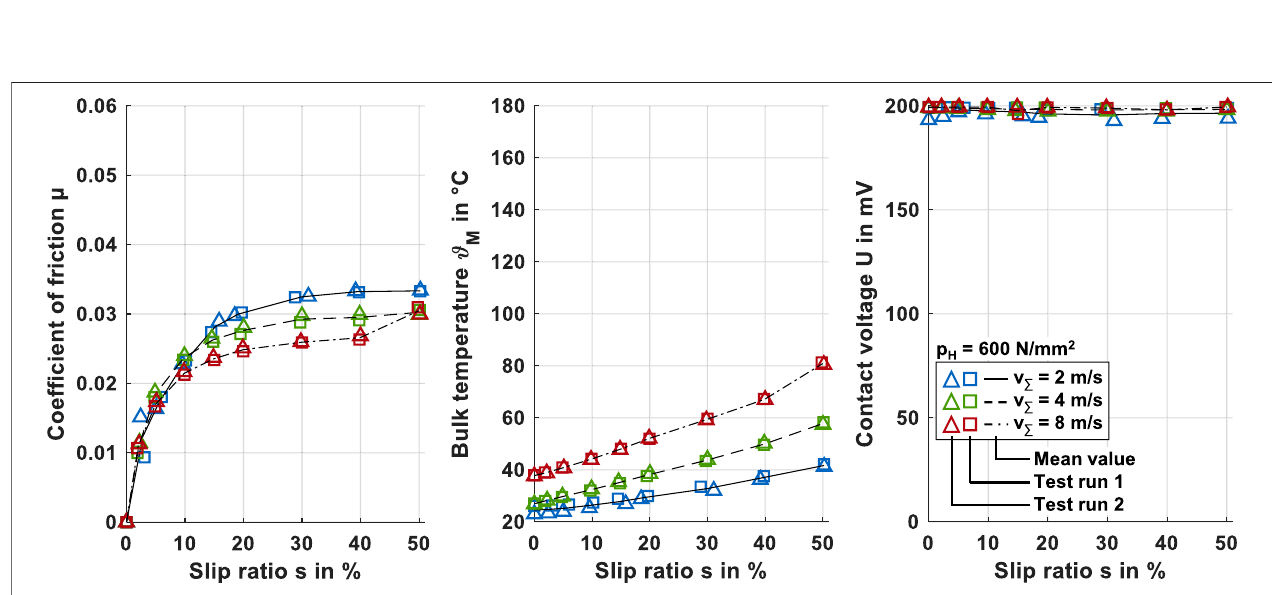
FIGURE8| Measured coef fi cients offriction μ , bulktemperatures ϑ M and contact voltages Uover slipratiosforp H (cid:1) 600 N/mm 2 and v Σ (cid:1) {2,4,8} m/sunderDoD lubrication at the twin-disk tribometer.